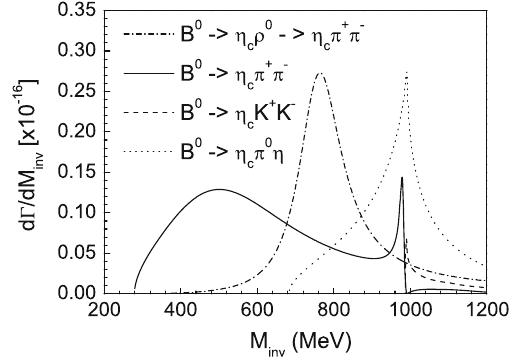
Fig. 4 π + π − , π 0 η ,and K + K − invariantmassdistributionsfor ¯ B 0 → + K − , and η π + π − , η π 0 η , respectively η c c K c